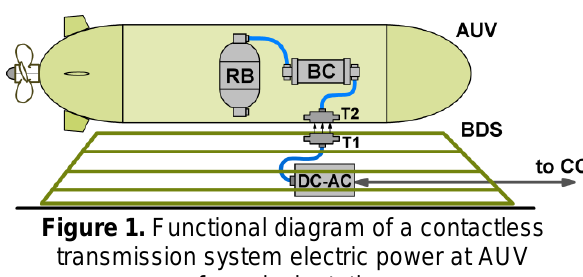
Figure 1. Functional diagram of a contactless transmission system electric power at AUV from